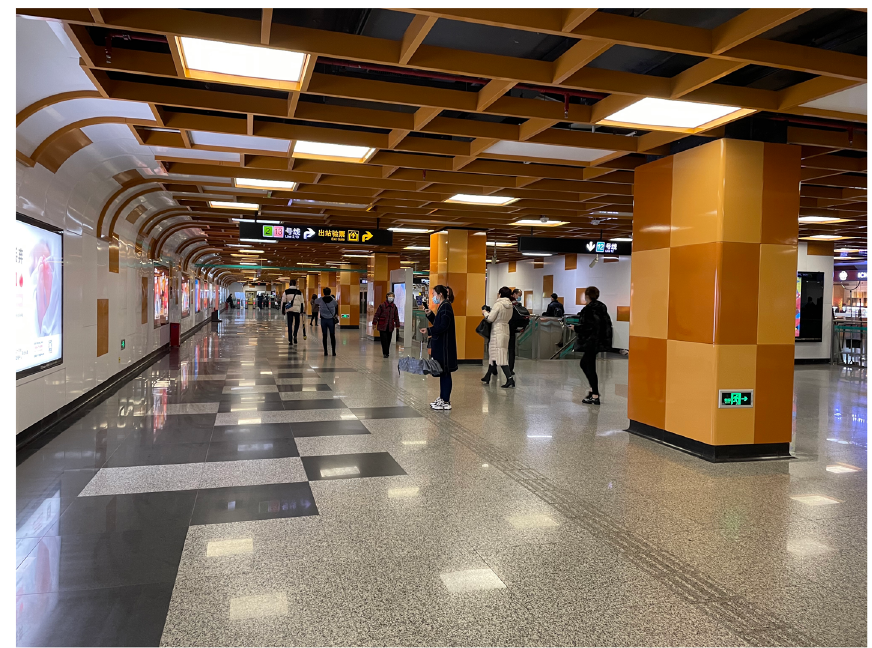
Fig. 8 The ‘ reverberance ’ of the stone lintels of shikumen gates in the curved transition between walls and ceilings in West Nanjing Road Station. (Source: the author)